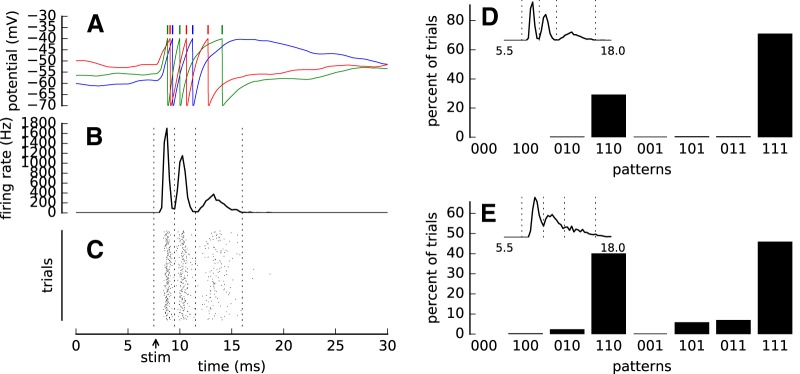
A LIF model produces variable spike patterns. A, Sample traces of the membrane potential Vm(t) of a LIF model (see Methods for details) for three repetitions of the simulation. The ticks mark the threshold crossings, which lead to spike emission (color matched to the color of Vm trace). B, Poststimulus time histogram (firing rate) of spike trains obtained from 500 repetitions of the simulation. Vertical dashed lines delineate the events used for spike pattern analysis in D. C, Spike raster from all repetitions of the simulation. The “stim” arrow denotes the onset of the simulated thalamic inputs. D, Distribution of spike patterns obtained in the simulation of a LIF neuron (inset, PSTH). E, Distribution od spike patterns and PSTH (inset) for a model with modified parameters. Increasing the presynaptic firing rates of intracortical connections leads to higher coincidence of 101 and 011 patterns. In A-D the following parameters were used: wexc = 0.0072 μs, τexc = 0.9 ms, fexc = 10 Hz, winh = 0.02252 μs, wTh = 0.035 μs, nTh = 28, fTh = 700 Hz, U = 0.65. E, Four parameters were modified from this baseline: fexc = 30 Hz, wTh = 0.05 μs, fTh = 300 Hz, U = 0.7. All definitions and values of the remaining parameters are listed in Table 1.